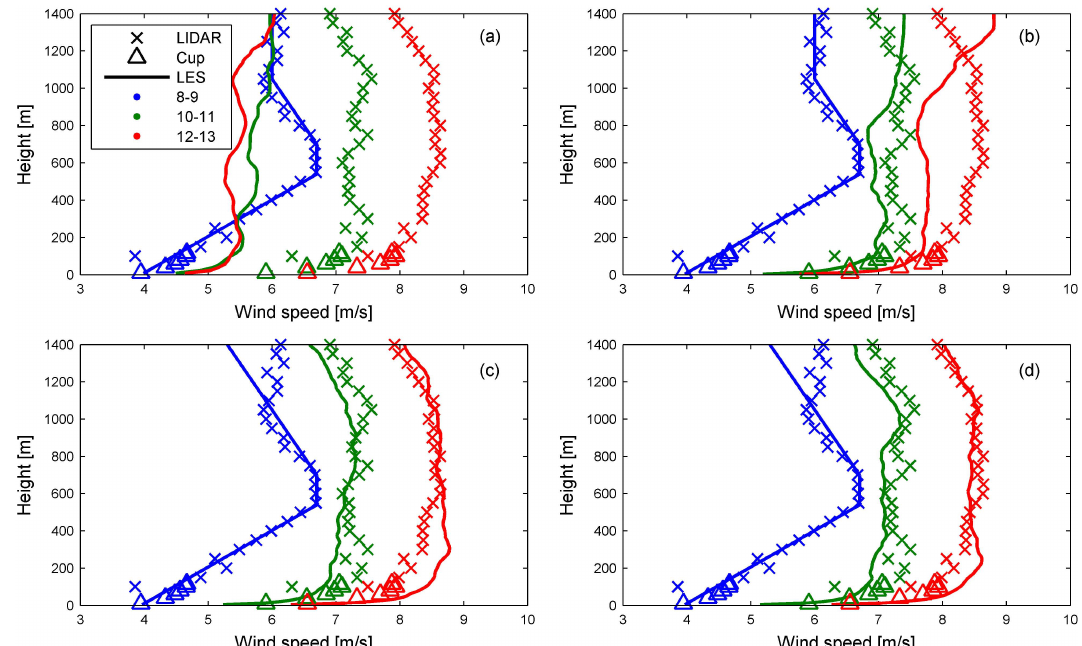
Figure 1. Wind speeds from simulations A, B, C and D compared to measurements.